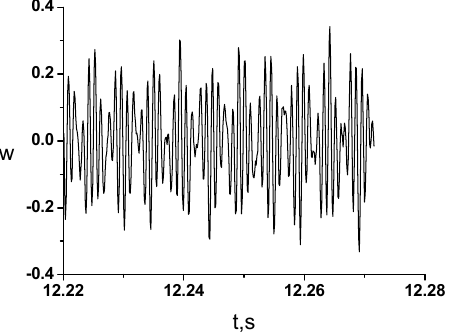
Figure 10. High-frequency oscillations. The scaling factor is equal to 1.